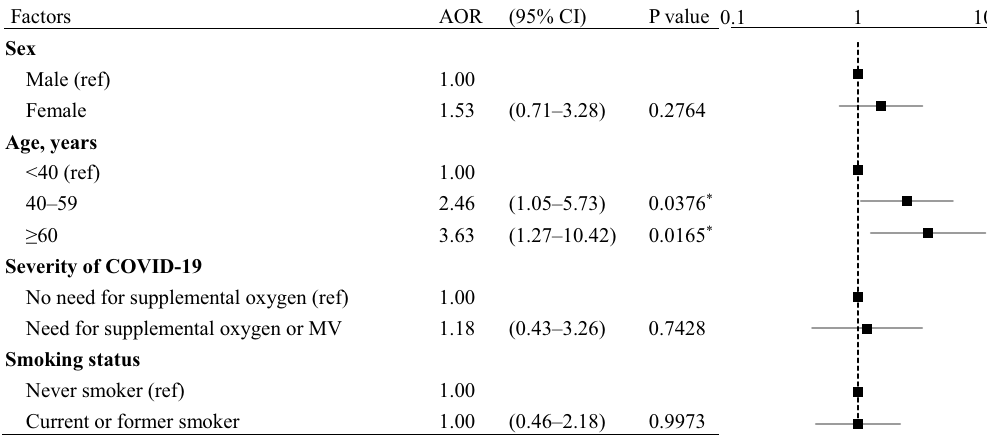
Table 2. Multivariate analysis results of risk factors for long COVID. N = 127, R 2 = 0.0546, Model p = 0.0874. Data were analyzed using multivariate logistic regression analysis. The response variable was the presence or absence of sequelae. The following explanatory variables were entered into the model simultaneously (forced entry): sex, age, severity of COVID-19, and smoking status. Moreover, the stepwise variable selection method was employed to determine appropriate explanatory variables from among the following comorbidities: hypertension, diabetes mellitus, COPD, malignancy, and cerebrovascular disease. Asterisks (*) indicate statistically significant differences. AOR adjusted odds ratio, CI confidence interval, ref reference, MV mechanical ventilation.